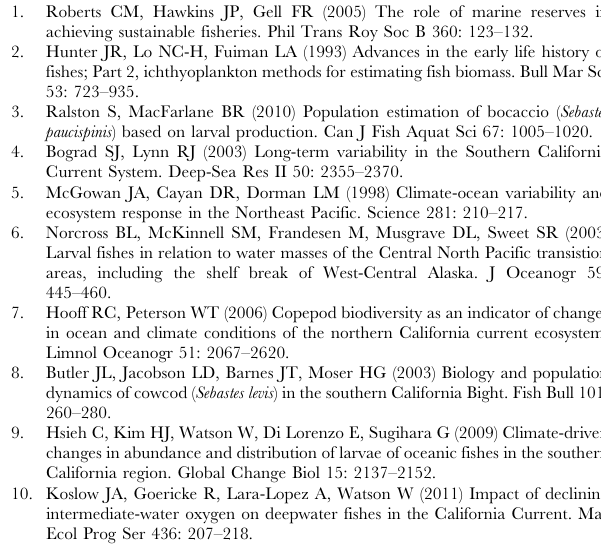
Figure S5 Hellinger-transformed values of oceanic species in the CalCOFI domain from 2002–2004. (A–C) Nanobrachium ritteri; (D–F) Protomyctophum crockeri ; (G–I) Symbolophor- ous californiensis . (TIF) Figure S6 Hellinger-transformed values of two oceanic and one coastal-oceanic species in the CalCOFI domain from 2002–2004. (A–C) Diogenicthys atlanticus (oceanic); (D–F) Stenobrachius leucopsarus (oceanic); (G–I) Leuroglossus stilbius (coastal- oceanic). (TIF) Figure S7 Hellinger-transformed values of coastal-oce- anic species in the CalCOFI domain from 2002–2004. (A– C) Lipolagus ochotensis ; (D–F) Merluccius productus ; (G–I) Engraulis mordax . (TIF) Figure S8 Hellinger-transformed values of benthic taxa in the CalCOFI domain from 2002–2004. (A–C) Sebastes spp.; (D–F) Sebastes jordani ; (G–I) Sebastes paucispinis . Table S1 Complete list of taxa sampled in the Cowcod Conservation Area and